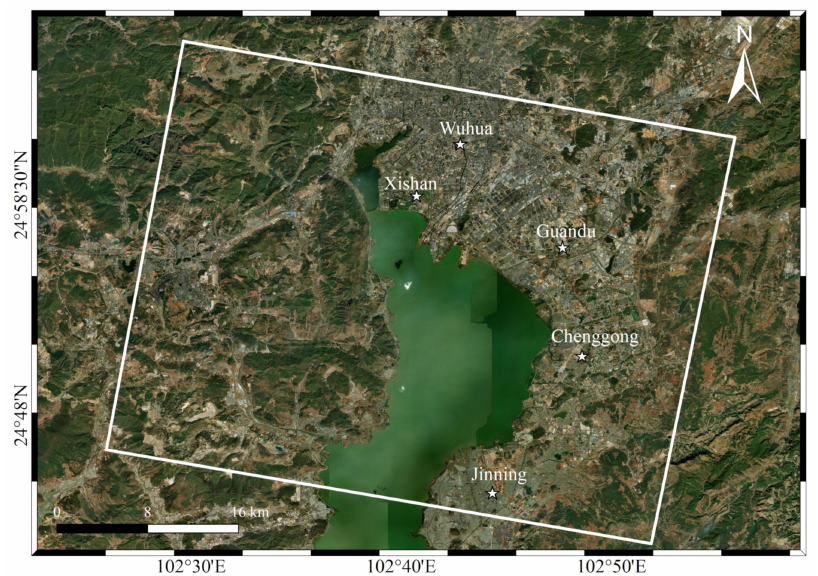
Figure 7. Study area(including the main urban area of Kunming and its